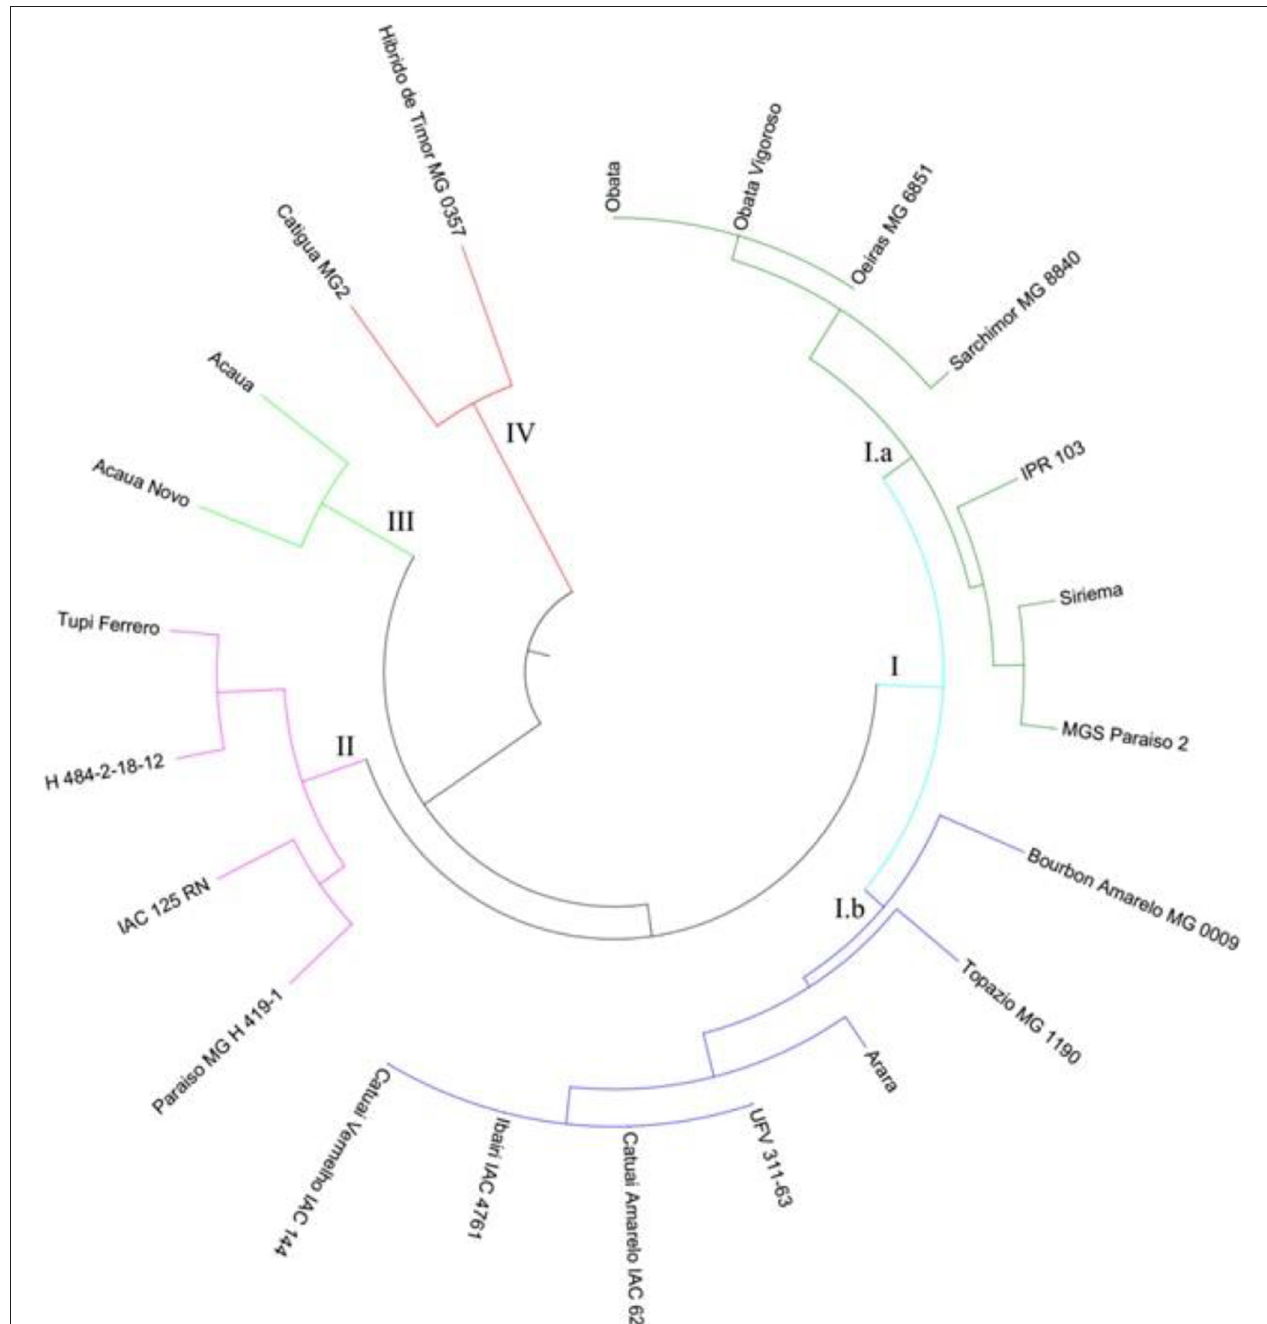
FIGURE 1 | Dendrogram based on the analysis of 12 SSR markers in 22 cultivars/accessions of Coffea arabica , obtained by the UPGMA technique, using the dissimilarity matrix of the weighted index arithmetic complement.